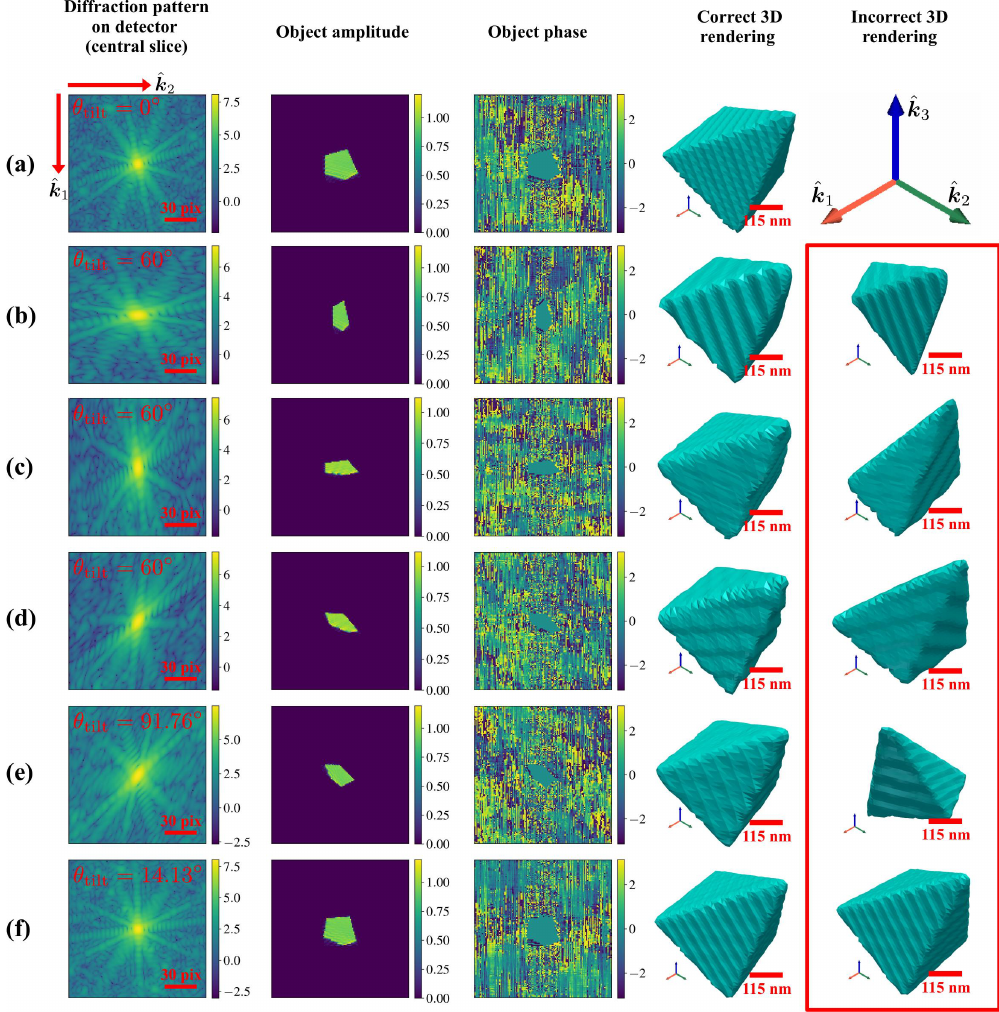
Figure 4. Simulations of the signal distortion and object reconstructions, for different detector tilts. The simulation in each row corresponds to the same simulated pyramid being mounted in exactly the same manner in the diffractometer prior to forward propagation, with the only change being in the detector tilt. ( a ) The no-tilt case of conventional BCDI, in which the detector is normal to the exit beam. The first image shows the central slice of the measured 3D diffraction pattern. The second and third images are the central amplitude and phase cross-sections of the “reconstructed” object (i.e., a simple inverse FFT). The fourth image is the inferred object isosurface corresponding to the tilt-corrected sampling basis B real (see [23]). ( b – f ) The corresponding images for various non-zero detector tilts parameterized by the angles ξ , ζ , and φ (see Appendix A and Table A2 for the definitions and specific values). In each of the subfigures ( b – f ), the last image is the inferred object if the detector tilt is not taken into account, and it is naively assumed that the detector is perpendicular to the exit beam, as in conventional BCDI. In each of the diffraction patterns (first column), the red bar indicates a span of 30 pixels. We note that in ( e , f ), the additional tilt φ (cid:54) = 0 about the nominal exit beam direction implies that the diffraction pattern is rotated relative to the aperture presented by the tilted detector. From this, it follows that the naively reconstructed object would be rotated as well, in addition to exhibiting tilt-induced shear. This is indicated by the differently oriented pyramids, unlike the results in ( b – d ), for which φ = 0 ◦ . This example illustrates the ease with which the presented formalism can address tilt-, as well as rotation-induced distortions in the measured diffraction